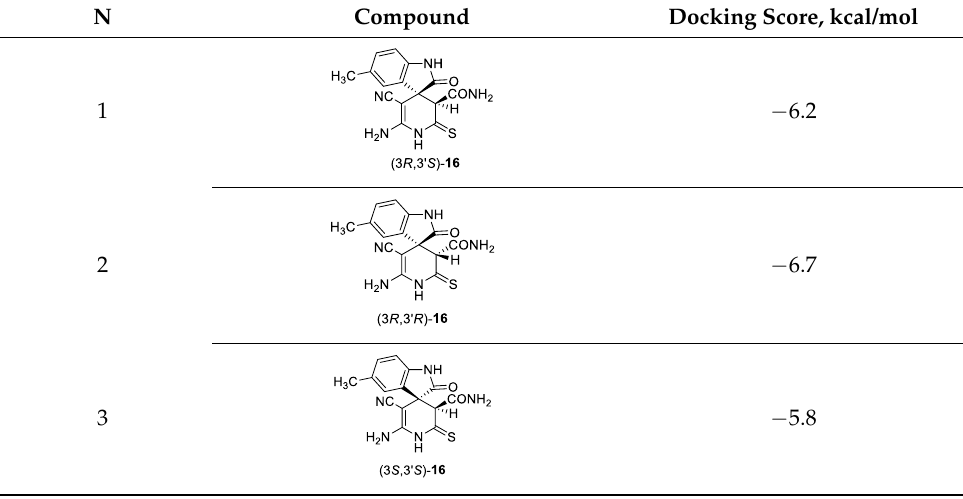
Table 1. The results obtained from the rigid docking studies for stereoisomers of compounds 16,17a,b against bacterial transcriptional regulator protein PqsR of Pseudomonas aeruginosa (PDB ID 4JVC).